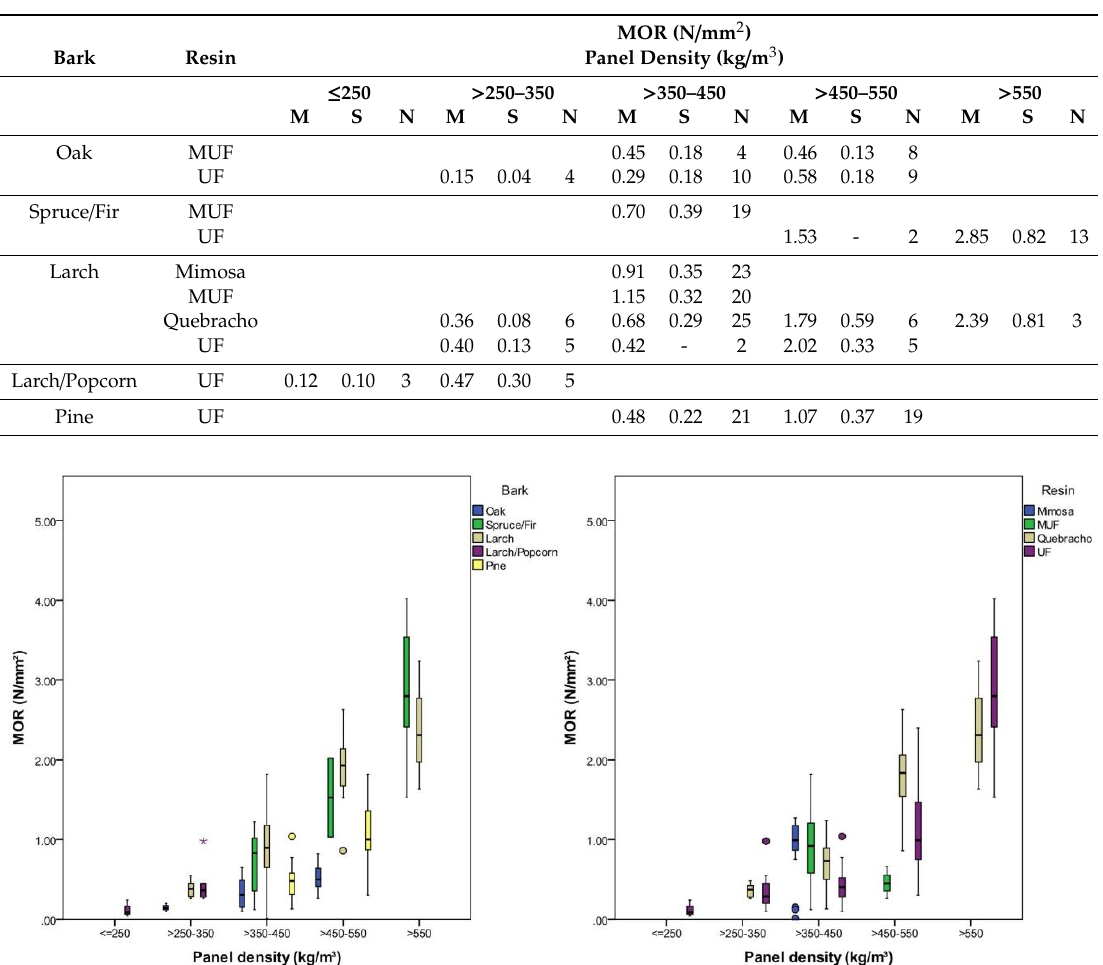
Figure 4. MOR of the investigated panels according to panel density, bark type and resin type. Table 5. MOR dependent on bark and resin type.